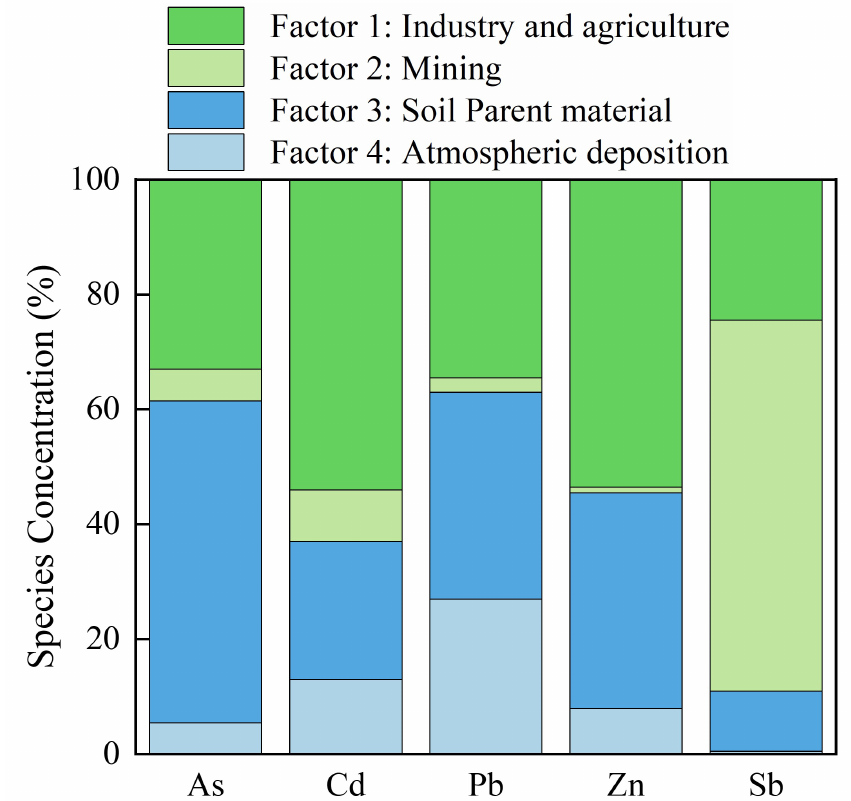
Figure 10. Sources of soil heavy metals and metalloids in the study area according to the results of the positive matrix factorization (PMF)